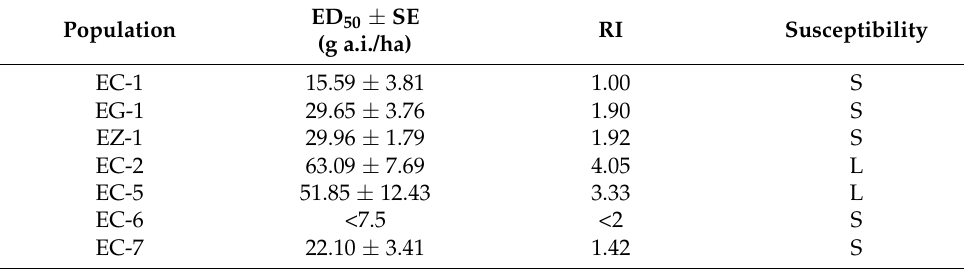
Table 5. The susceptibility of different E. spp. to metamifop.